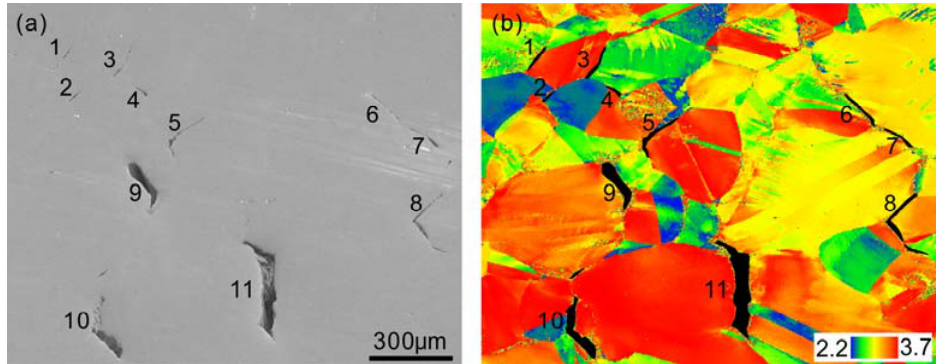
Figure 7. Morphology of cracks in a specimen with a grain size of 177 μ m and with precipitates tension tested to a strain of 0.27: ( a ) SEM map and ( b ) Taylor factor map. Horizontal direction is the tensile direction.